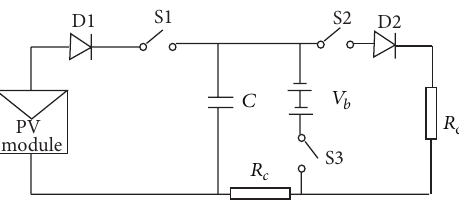
Figure 3: PV module biasing with capacitor load.